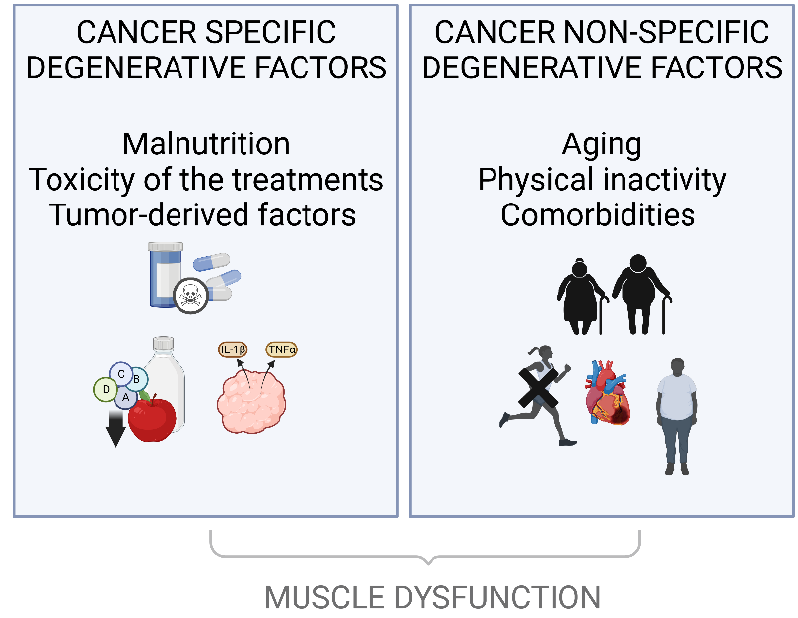
Figure 2. Cancer-specific (malnutrition, treatment associated toxicities and tumor derived factors) and non-specific (aging, physical inactivity and comorbidities) degenerative factors causing muscle dysfunction in patients with cancer. Created with BioRender.com.